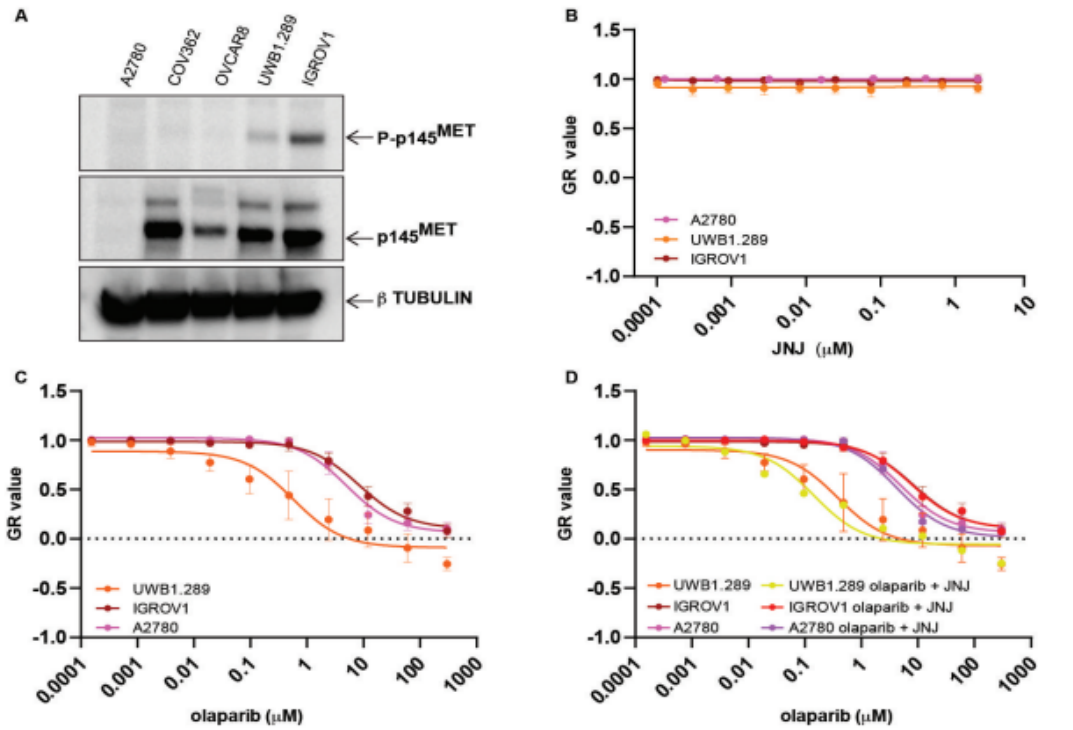
Figure 3. Growth rate of ovarian cancer cell lines treated with the PARP inhibitor olaparib with or without the MET inhibitor JNJ-38877605 (JNJ), evaluated using a 5-day crystal violet assay. Normal- ized growth rate (GR value) inhibition metrics have been used as described in the legend to Figure 2. ( A ) Expression (p145) and phosphorylation status (P-p145) of the 145 kDa MET receptor subunit in the ovarian cancer cell lines listed on the top. β tubulin was used as loading control. ( B ) Growth rate of the UWB1.289, IGROV1 and A2780 cells treated with the indicated μ M concentration of the MET inhibitor JNJ-38877605 (JNJ). ( C ) Growth rate of the UWB1.289, IGROV1 and A2780 cells treated with the indicated μ M concentration of olaparib. ( D ) Growth rate of the UWB1.289, IGROV1 and A2780 cells treated with the indicated μ M concentration of olaparib with or without the MET inhibitor JNJ (10 nM).